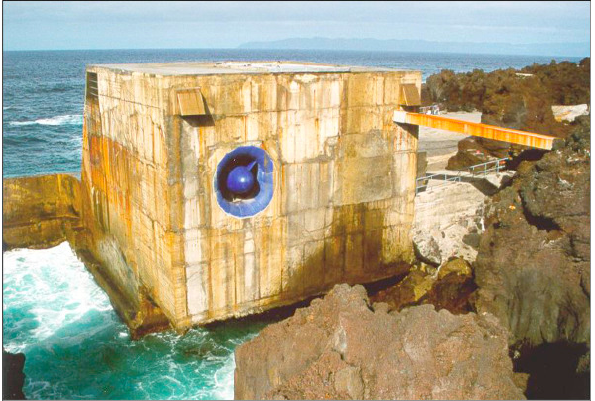
Figure 11. Back view of the OWC plant installed on the island of Pico (Azores, Portugal) (Reproduced with permission 5139250512092 from [50], Elsevier, 2016).